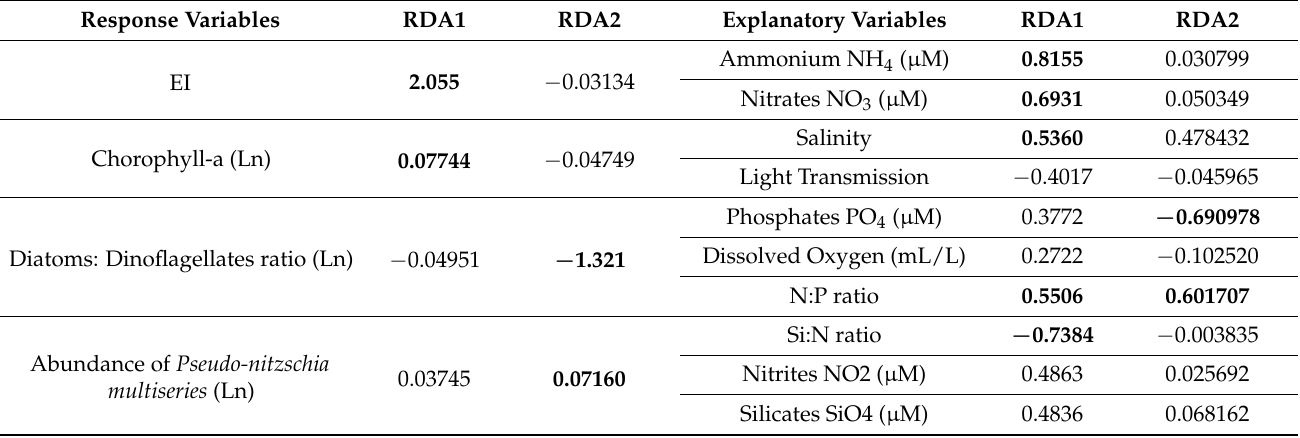
Figure 5. Corplot of Pearson and Spearman correlation analysis for the associations between the physicochemical and the biological parameters over the whole study area (J Pielou index, H Shannon index, SN total phytoplankton abundance, S total number of phytoplankton species, LnHAB abundance of potential harmful species, such as Ln, LnPseudo abundance of Pseudo-nitzschia multiseries as Ln, DO dissolved oxygen). Only significant correlations (at 0.05 or 0.01 significance levels) are presented in color. Table 2. Scores of explanatory and response variables for the first two axes of the Redundancy Analysis (RDA). Statistically significant explanatory variables are indicated in bold